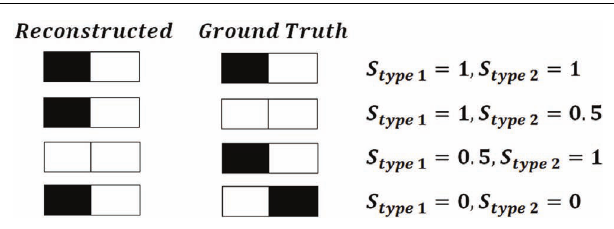
FIGURE 5 |An example of the behavior of similarity factors (similarity factor type 1 S type1 and similarity factor type 2 S type2 ) on simple planar example.